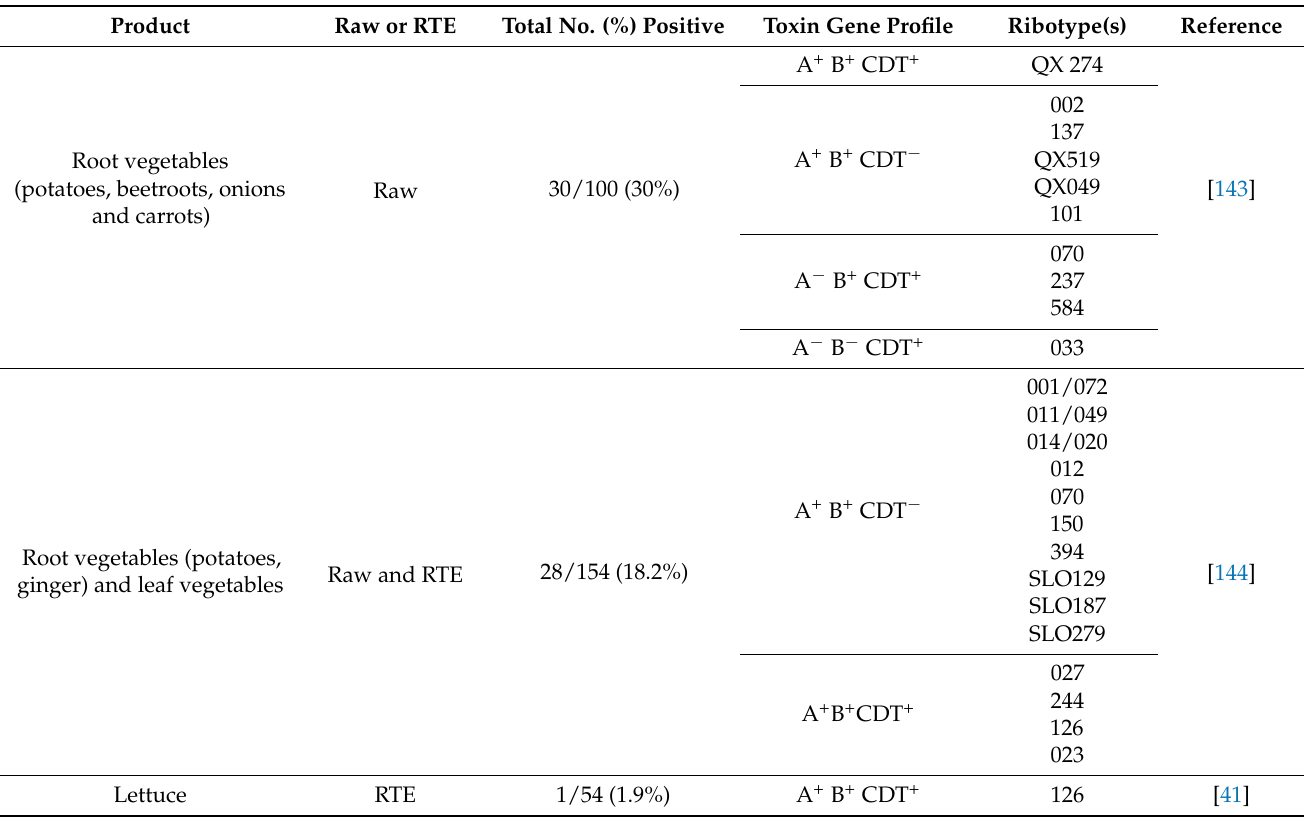
Table 3. Vegetable retail foods contaminated with C. difficile, including toxin gene profiles (toxins A, B and CDT) and